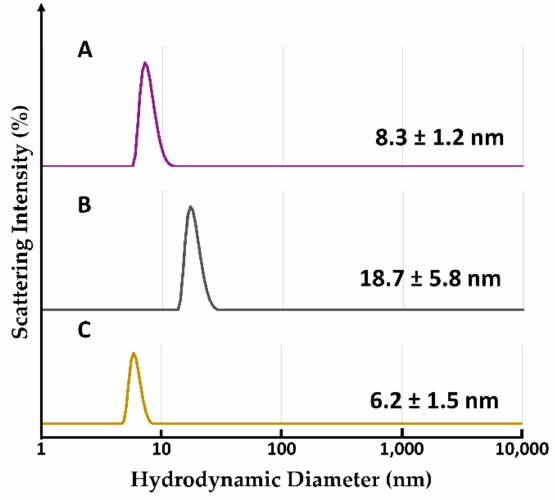
Figure 9. Hydrodynamic diameter distributions for ( A ) 1/1-( 1 -Cyt b 562N80C ) n -apoHTHP assembly, ( B ) 3/1-( 1 -Cyt b 562N80C ) n -apoHTHP assembly and ( C )